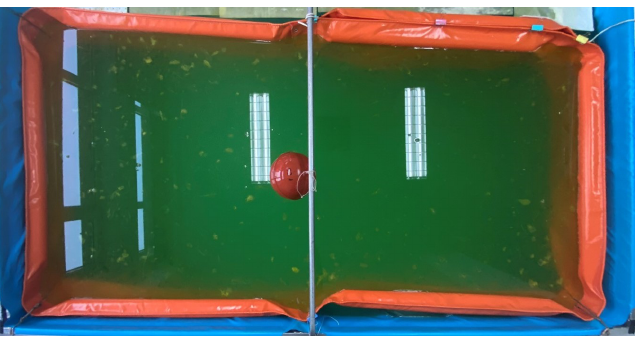
Figure 12. Test map for quantitative